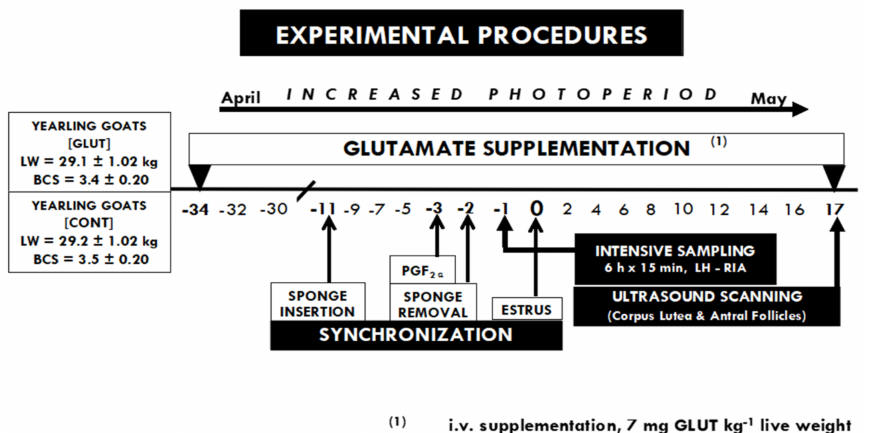
Figure 1. Time-line of activities performed during the experiment, including the estrous synchro- nization protocol and the targeted glutamate i.v.—supplementation every third day along with the experimental period, (L-glutamate, from day 34 pre-estrus to day 17 post-estrus). Blood sampling (every 15 min × 6 h) for LH quantification was performed 24 h prior to the estrus day (day 0). Later, ovarian ultrasonographic assessment was carried out on day 17 post-estrus to study the relationship between the TOA and LH secretion pattern. All the experimental units had ad libitum water access and shaded areas in each